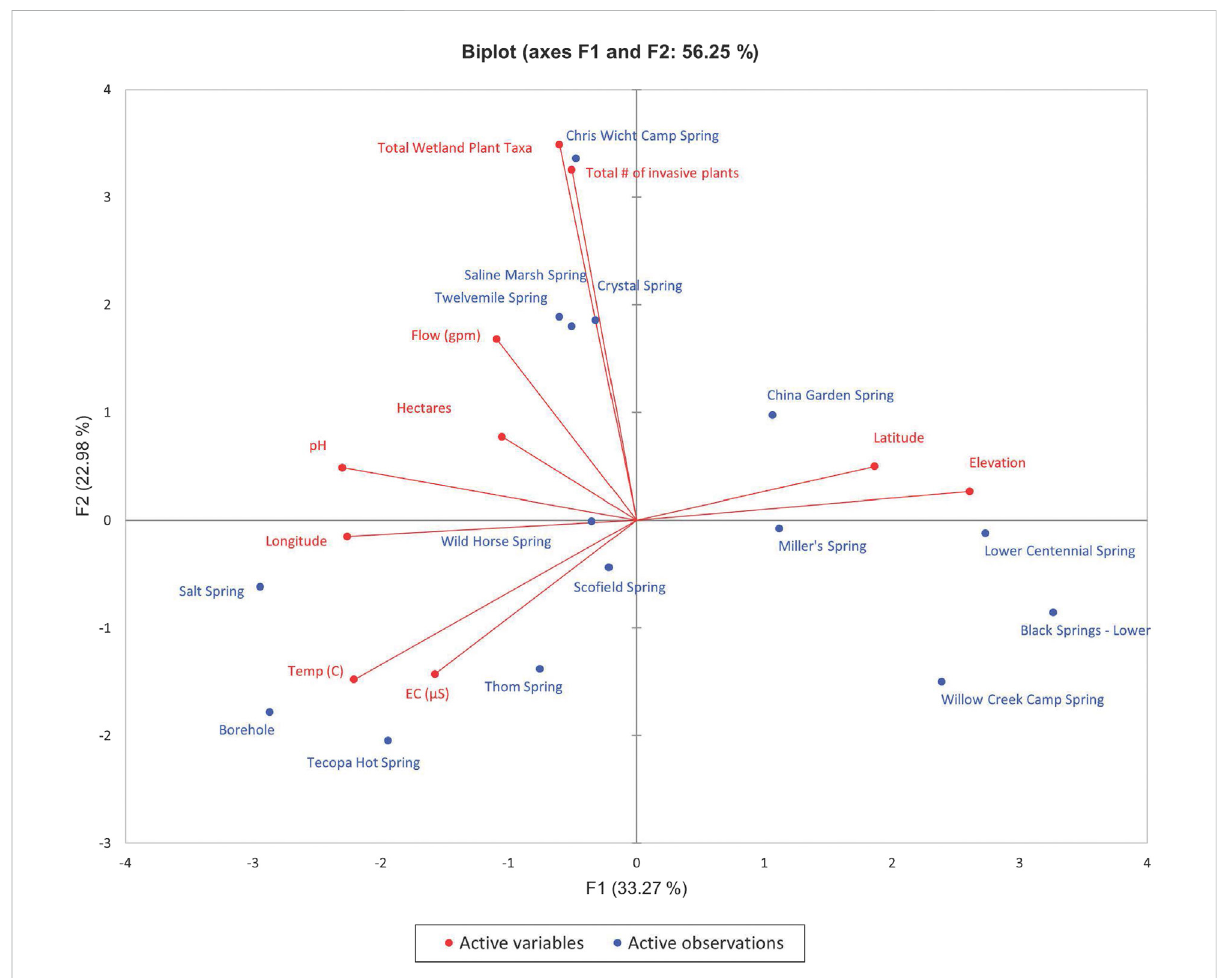
FIGURE 5 PCA biplot of F1 and F2 for ecohydrological dataset for the Northern Desert